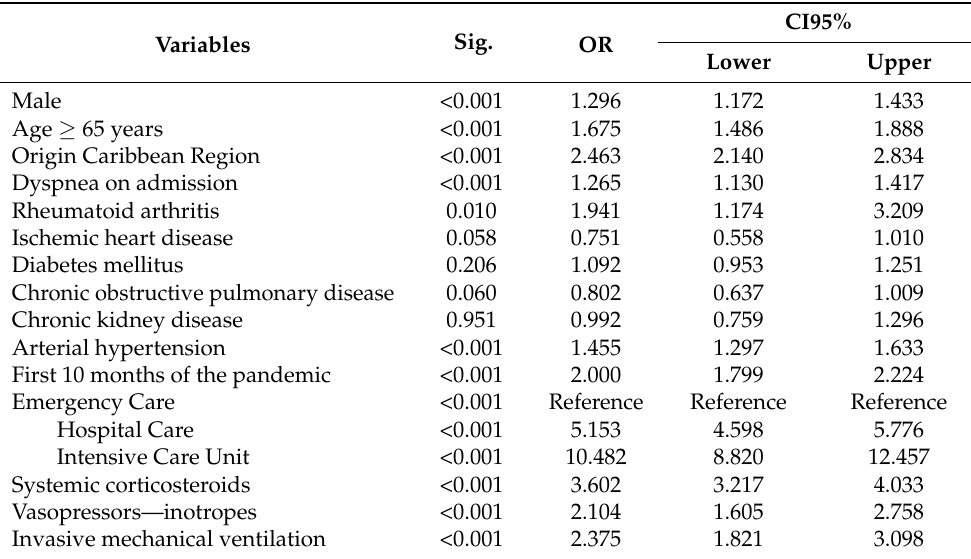
Table 3. Binary logistic regression of the variables related to receiving antibiotics in 10,916 patients with a diagnosis of COVID-19 treated in eight highly complex clinics in